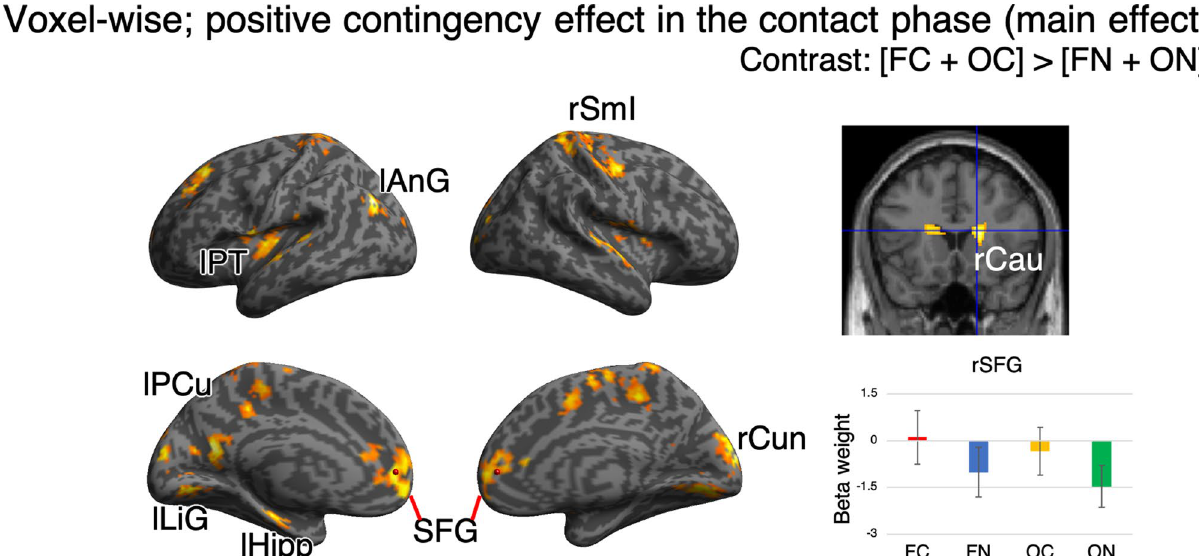
Figure 4. Brain activation representing a positive contingency effect. Brain activation during the contact phase representing a positive contingency effect in voxel-wise analysis. Other details correspond with those in Fig. 3A. SFG superior frontal gyrus, lHipp left hippocampus, lAnG left angular gyrus, lPT left planum temporale, lPCu left precuneus, LiG lingual gyrus, rSmI right primary somatosensory cortex, rCau right caudate, rCun right